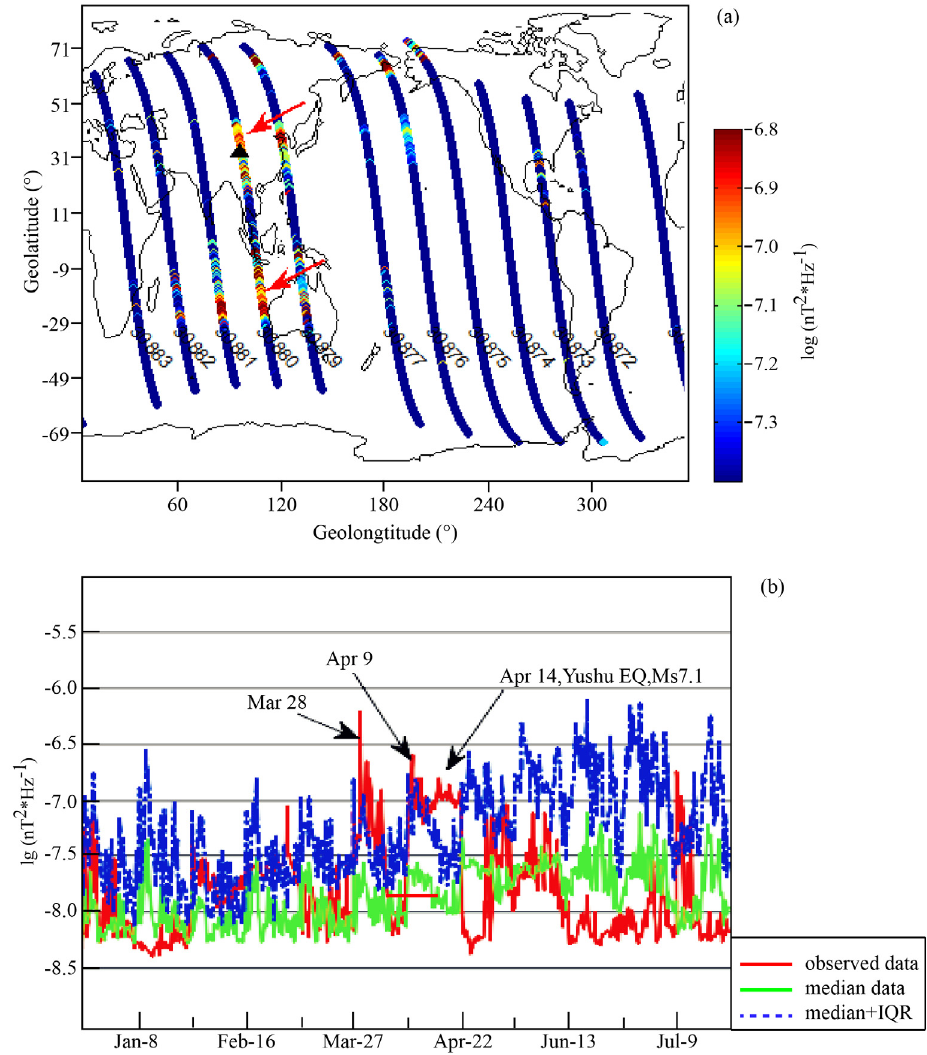
Figure 2. The global distribution of PSD of magnetic field at 410 Hz recorded by IMSC on April 9, 2010 (b), the black triangle represents the epicenter, and the two red arrows indicate the enhanced PSD locations. And time series of the PSDs data of magnetic field at 410 Hz from January 8 to July 9, 2010 (b), the red, green, and blue curves denote the observed PSD value, the moving median, and the median data plus IQR, respectively [Zeren et al.